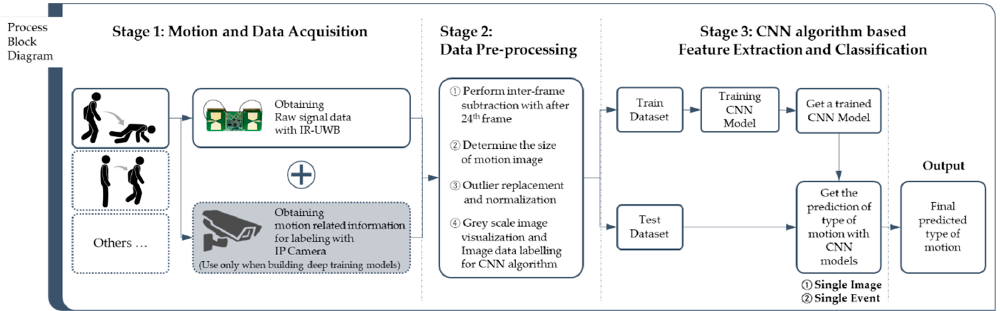
Figure 2. Proposed approach for fall detection using a convolution neural network.